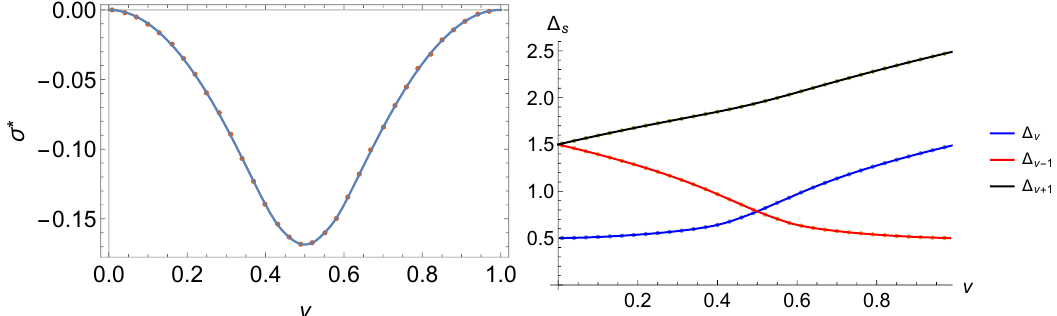
Figure 3. Saddle point value of σ ∗ and the dimensions of defect operators in three dimensional critical theory at large N . The solid lines are smooth interpolation of the numerical results. Note that the defect is one-dimensional, therefore the unitarity bound just requires the defect dimensions to be